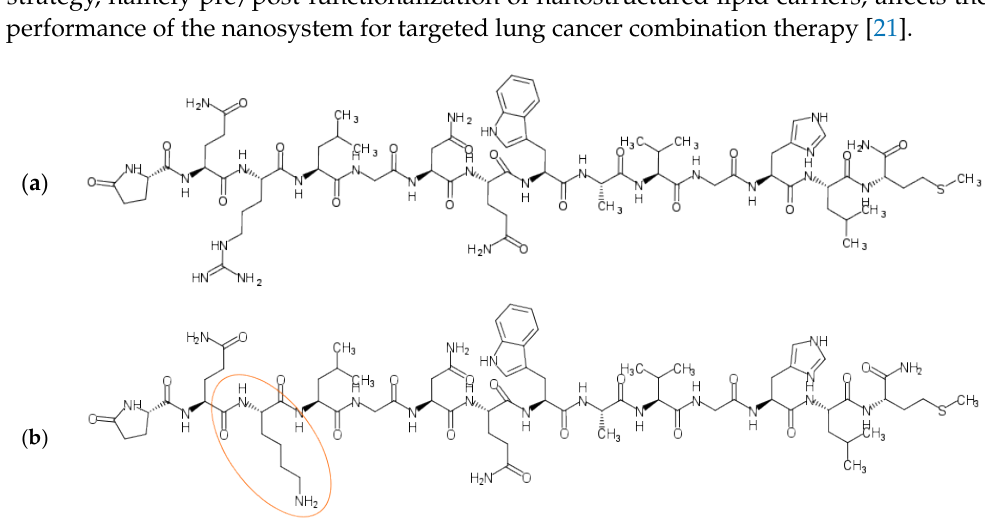
Figure 4. Structures of commercially available bombesin peptides: ( a ) BBN (Pyr-Gln-Arg-Leu-Gly- Asn-Gln-Trp-Ala-Val-Gly-His-Leu-Met-NH 2 ); ( b ) [Lys3]BBN (Pyr-Gln-Lys-Leu-Gly-Asn-Gln-Trp- Ala-Val-Gly-His-Leu-Met-NH 2 ). Lysine included in the modified BBN sequence is labeled orange. Sketched with MarvinSketch 22.13 (ChemAxon Ltd., Budapest, Hungary).